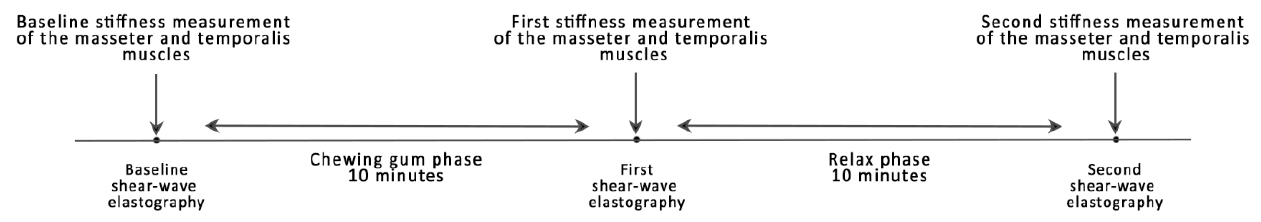
Figure 1. The study design.